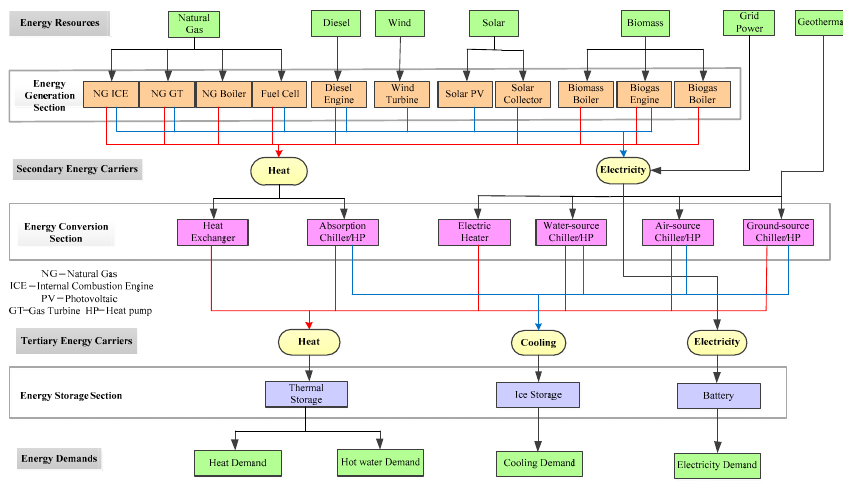
Figure 1. The general structure of the energy system.